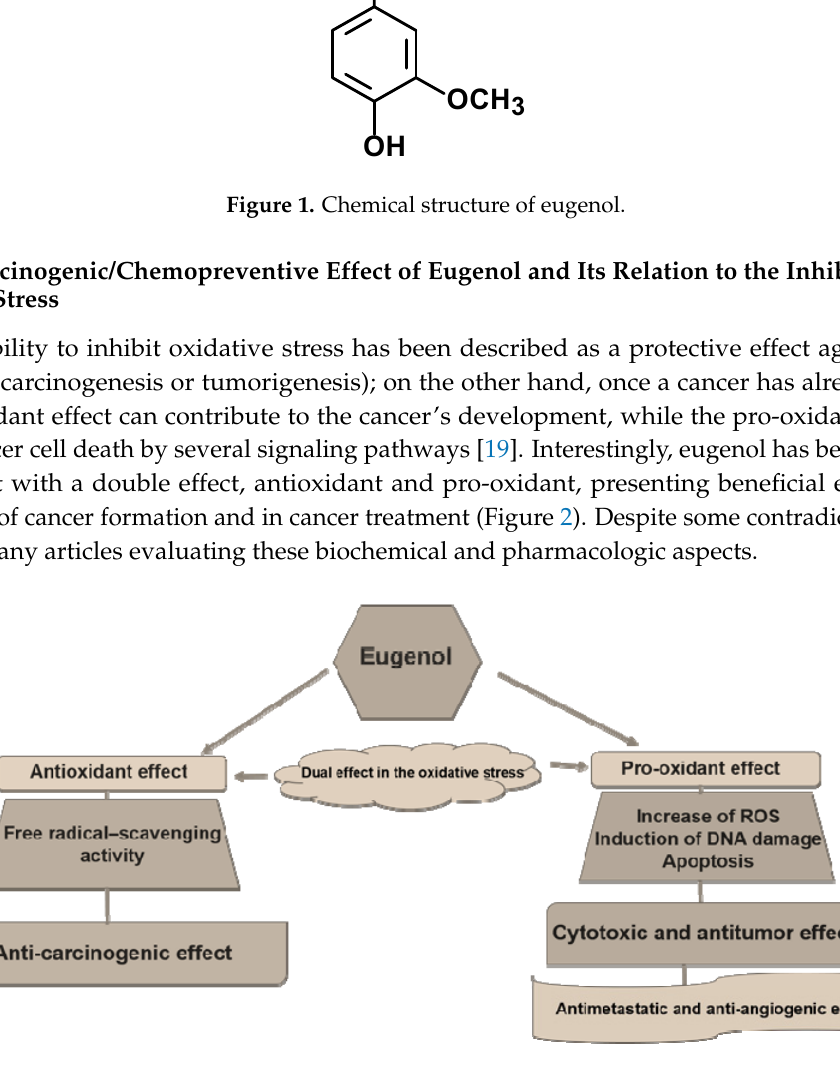
Figure 2. The dual effect of eugenol in the oxidative stress and its action in cancer development and treatment.